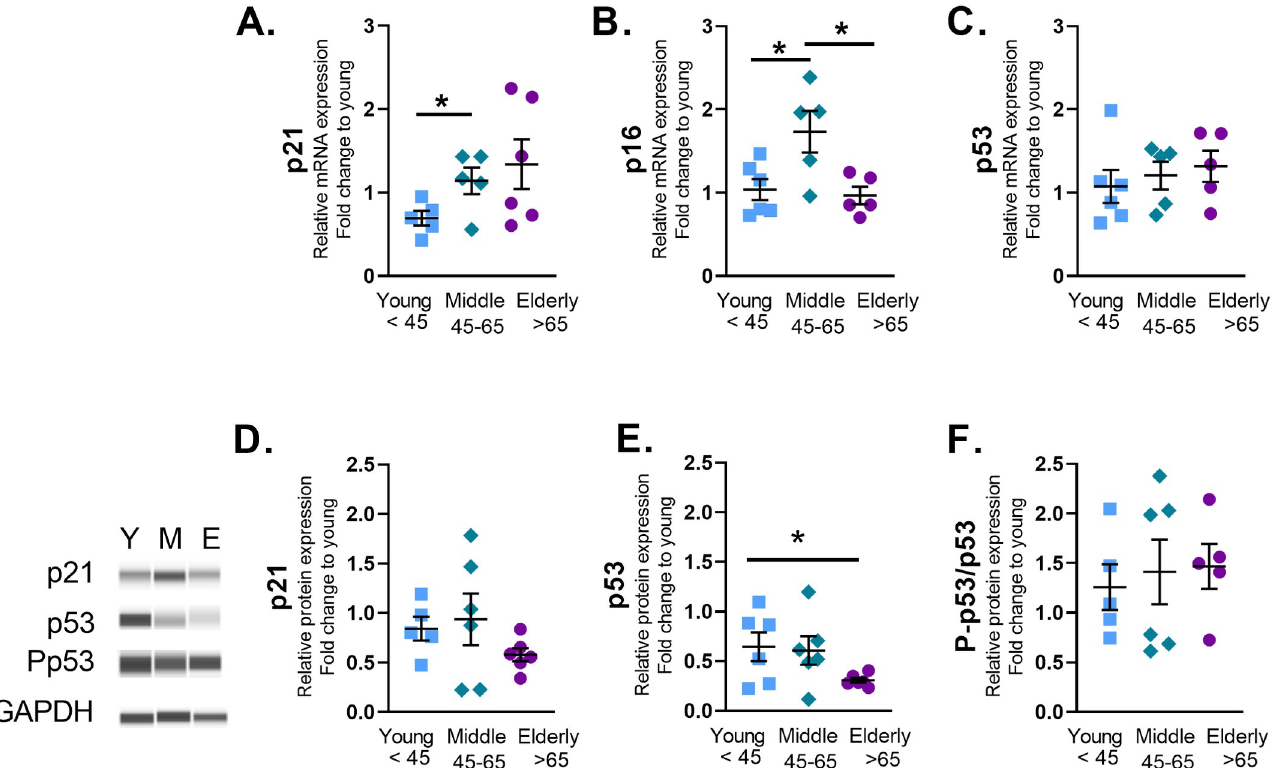
Fig 1. Aging increases senescence marker gene expression in human Airway Smooth Muscle (ASM) cells. mRNA was isolated from human ASM and p21, p16, and p53 gene expression was assessed by quantitative PCR. Compared to the young, p21 gene expression was increased in middle aged ASM cells (A). Senescent marker p16 was increased in middle aged ASM (B). Protein analysis for p21 (D), p53 (E) or p-p53 (F) normalized to GAPDH showed consistent changes for p53. Data are shown as mean ± SEM from N = 5–6 samples. Fold change was quantified against the average value of the samples from young individuals. � indicates significance P �